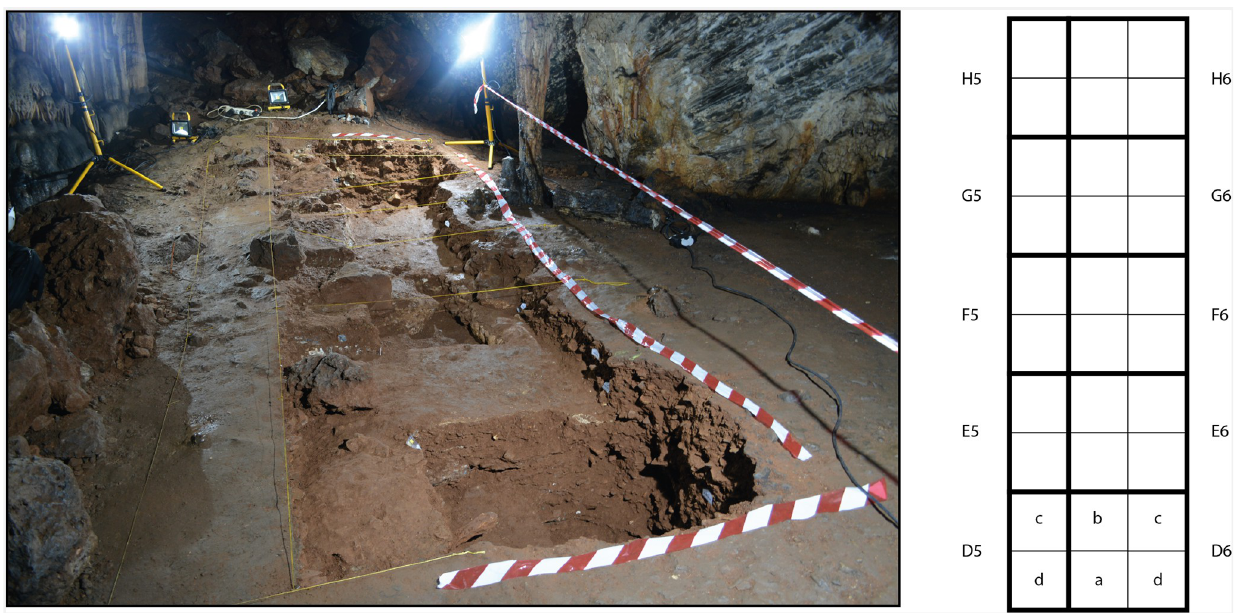
Fig 9. Post-excavation view of zone 5. The plan shows the arrangement of the excavation squares.